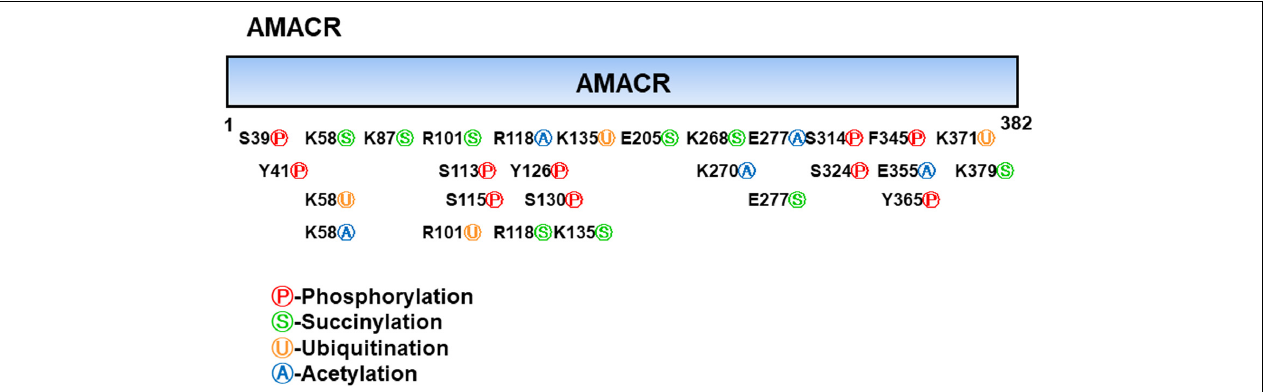
FIGURE 8 | Post-translational modifications of α -methyl acyl-CoA racemase (AMACR). AMACR domains range from 1 to 382 and many post-translational modification sites exist, including phosphorylation (red: S39, Y41, S113, S115, Y126, S130, S314, S324, F345, and Y365), succinylation (green: K58, K87, R101, R118, K135, E205, K268, E277, and K379), ubiquitination (yellow: K58, R101, K135, and K371), and acetylation (blue: K58, R118, K270, E277, and E355) [adapted from Hornbeck et al.